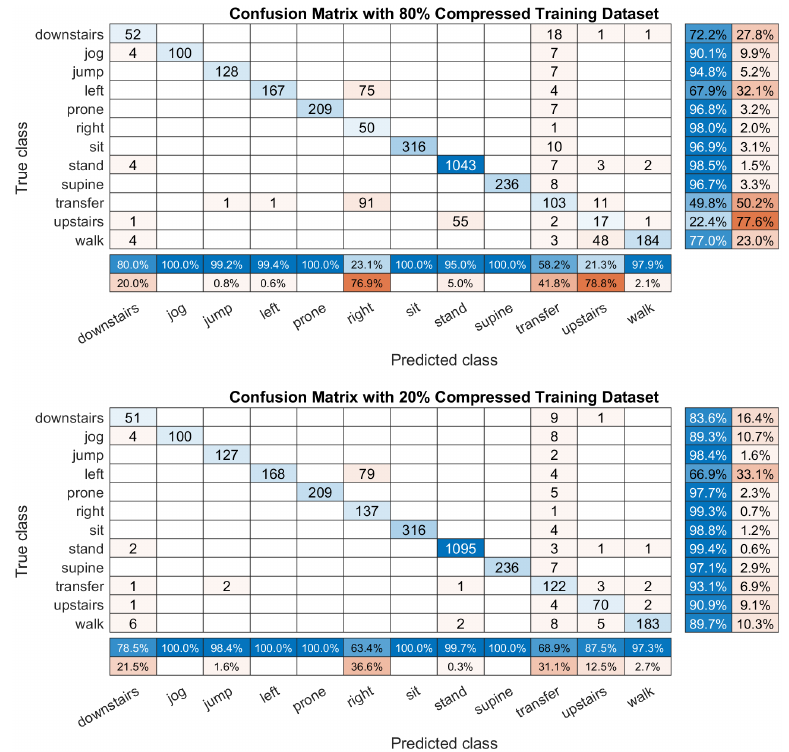
Figure 11. An example of the confusion matrix computed based on 80% and 20% compression training dataset. The top matrix is the prediction results computed by the DCNN classifier building on the 80% compressed dataset. The bottom picture is the results by the same classifier established on the 20% compressed training dataset. All of the matrix have a row summary to display the accuracy and the errors of each